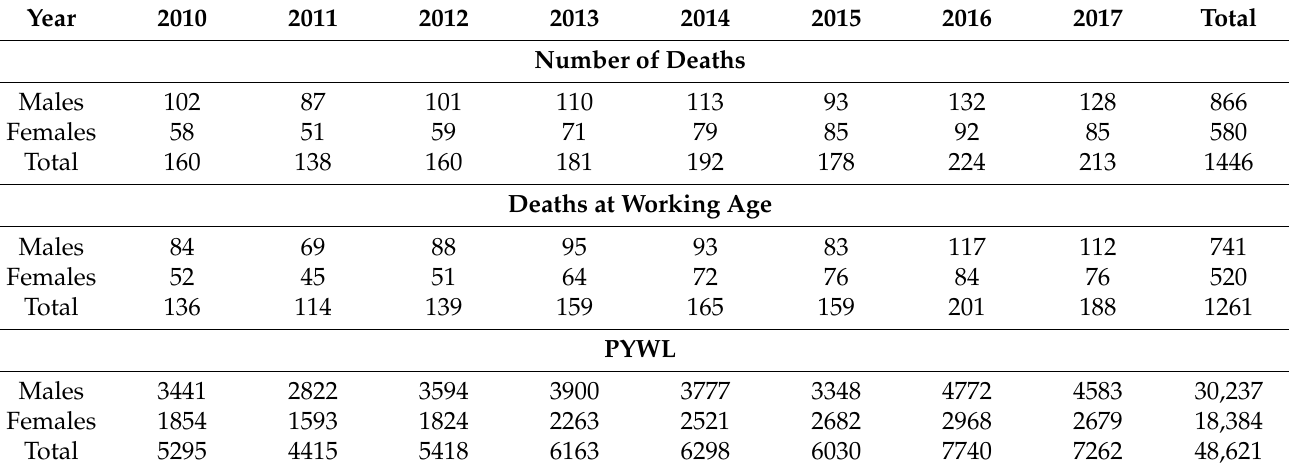
Table 1. The number of deaths and estimated Potential Years of Work Lost (PYWL) by sex from 2010 to 2017.